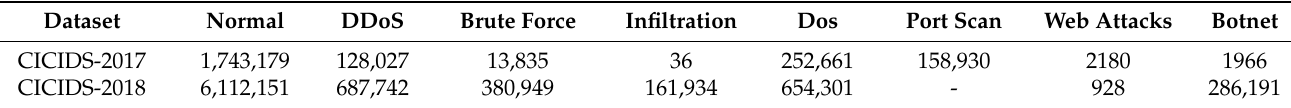
Table 2. Comparison of CICIDS-2018 ID dataset with